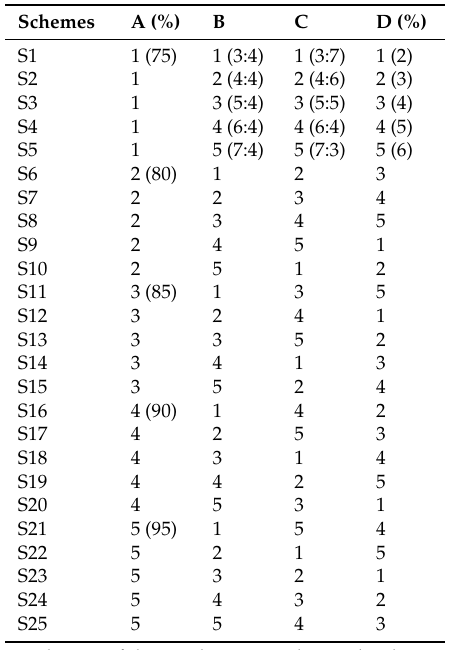
Table 2. The orthogonal test schemes of